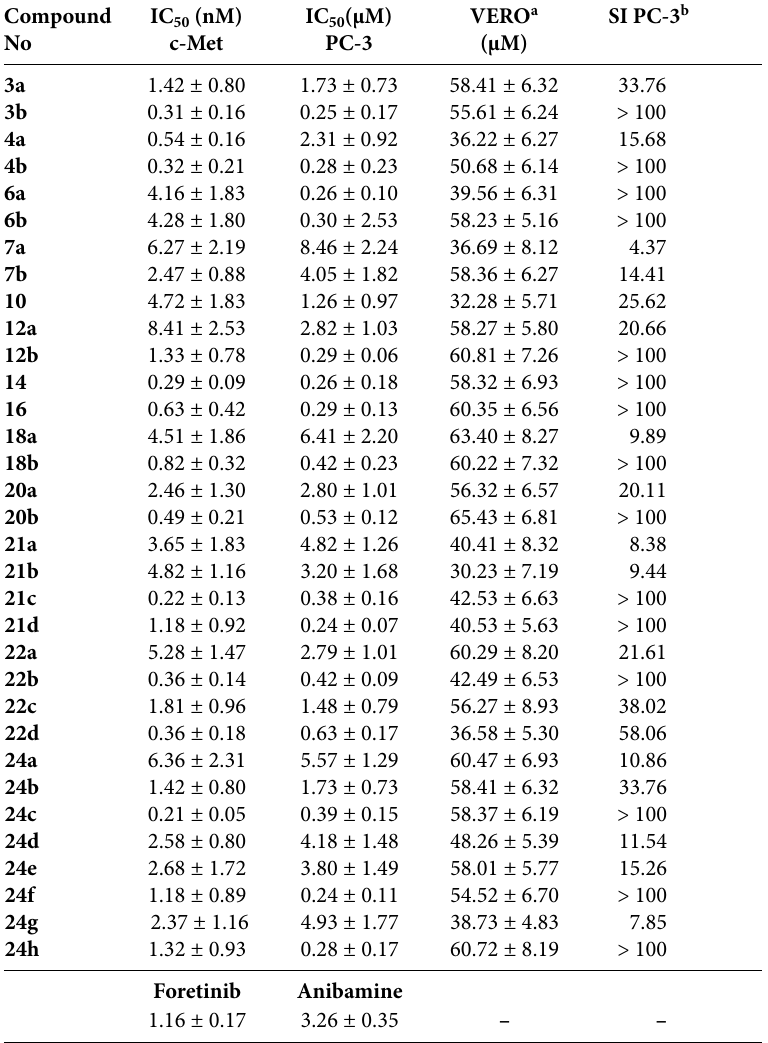
Table 2. c-Met enzymatic activity and PC-3 inhibition of the newly synthesized com- pounds.